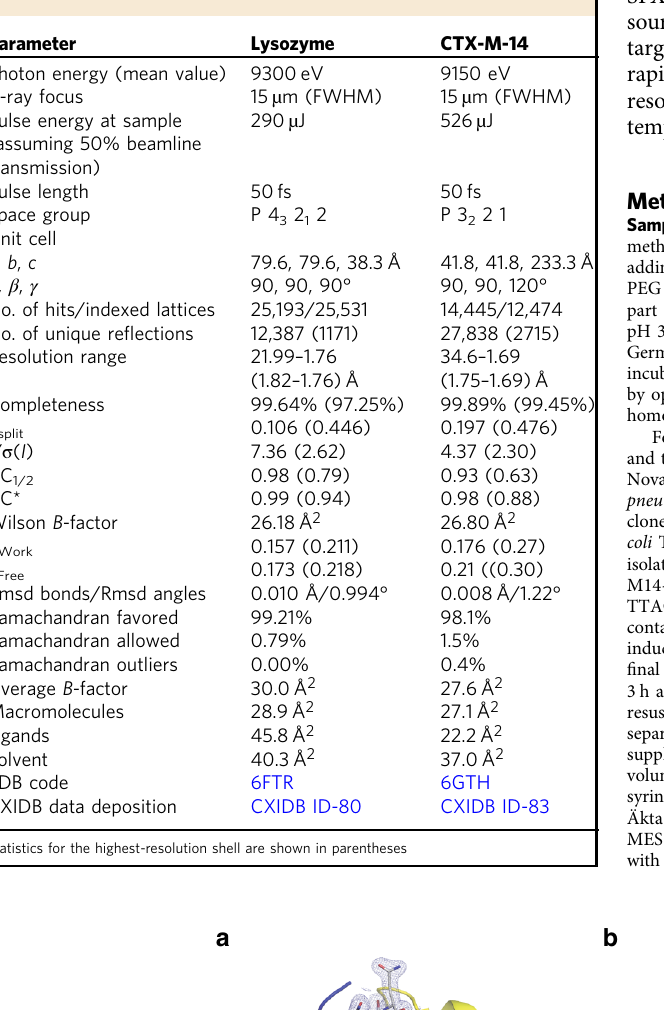
Table 2 SFX data and re fi nement statistics